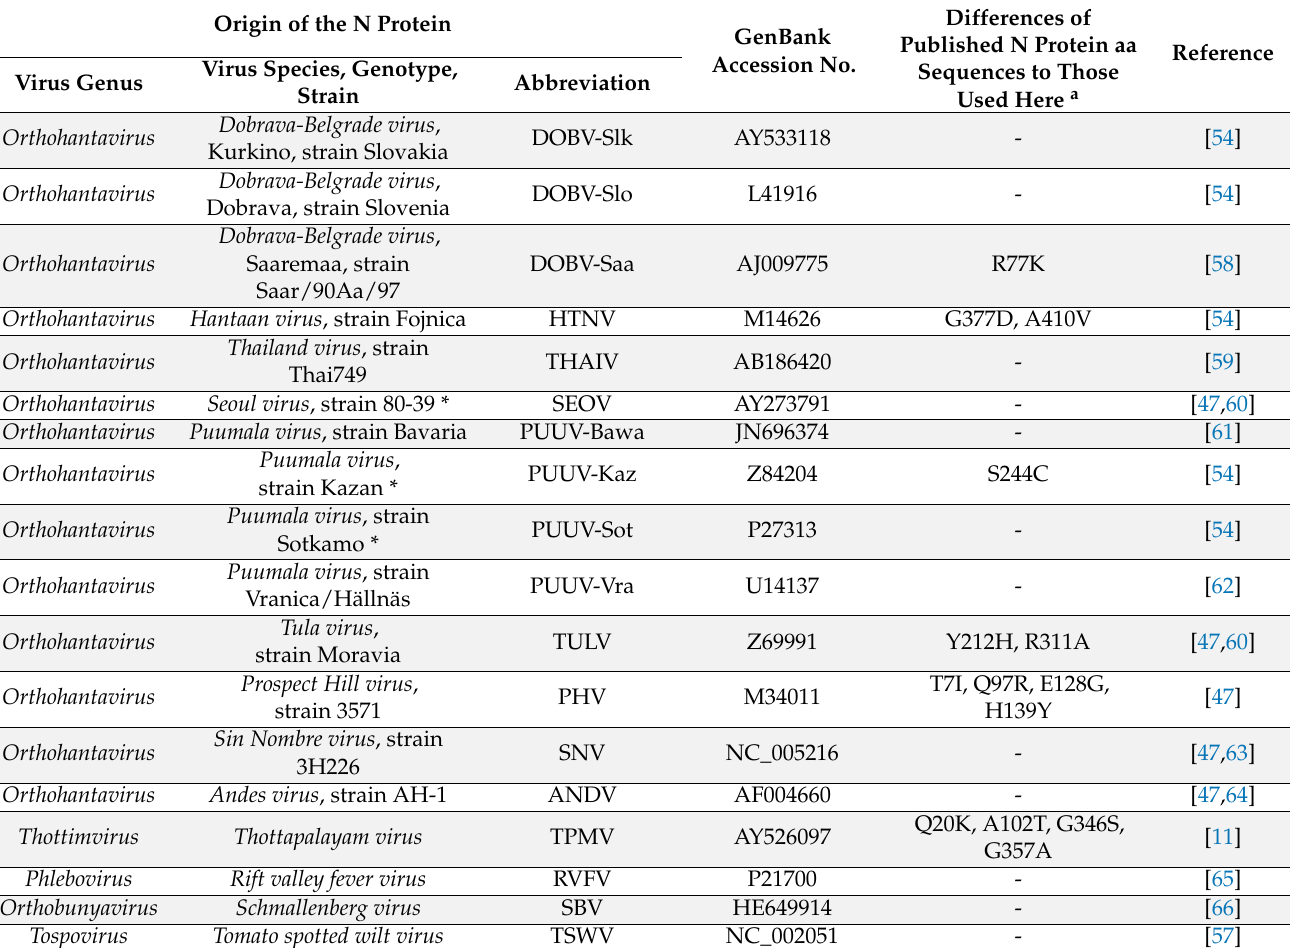
Table 1. List of His-tagged N proteins used for characterization of hantavirus-specific